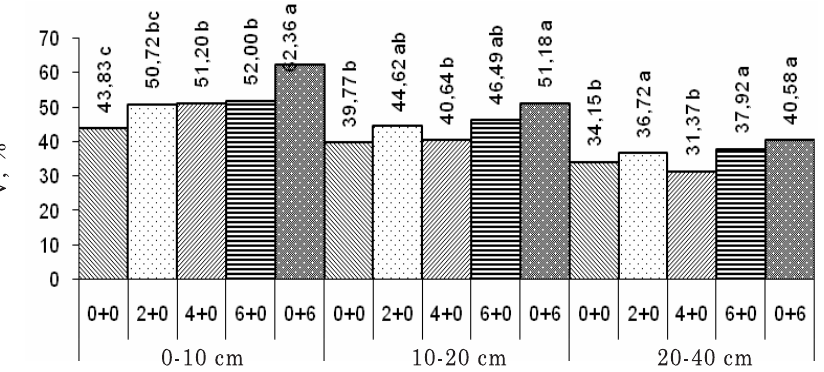
Figura 6. Médias de saturação por bases (%) no solo nas três profundidades avaliadas para os tratamentos com silicato de cálcio e calcário. Médias acompanhadas de mesma letra, dentro de profundidade, não diferem estatisticamente entre si pelo teste de Tukey.